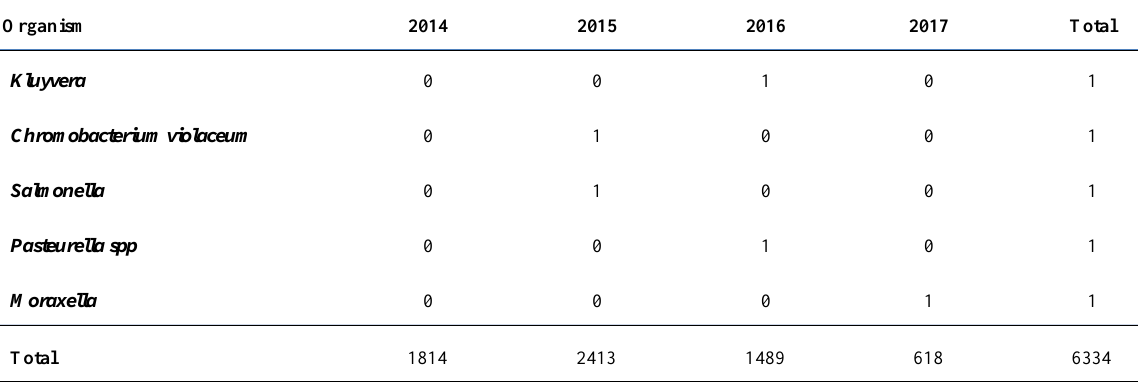
Table 1. Species identification of gram negative isolates. organism are excluded except for service utilization analysis. Confirmation of phenotypical presence of extended spectrum betal lactamases (ESBL) by Double Disk or minimal inhibitory concentration (MIC) and confirmation of AmpC status was not available. ESBL status attribution relied on disk diffusion interpreted as per CLSI, CDC and CESAR recommendations 6,14-19